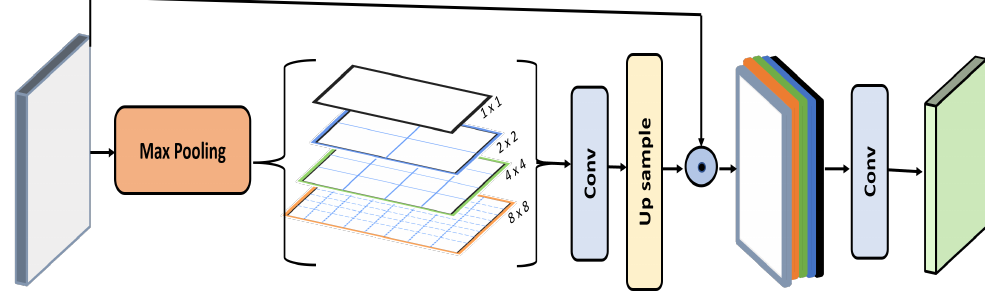
Figure 3. Structural diagram of bridge